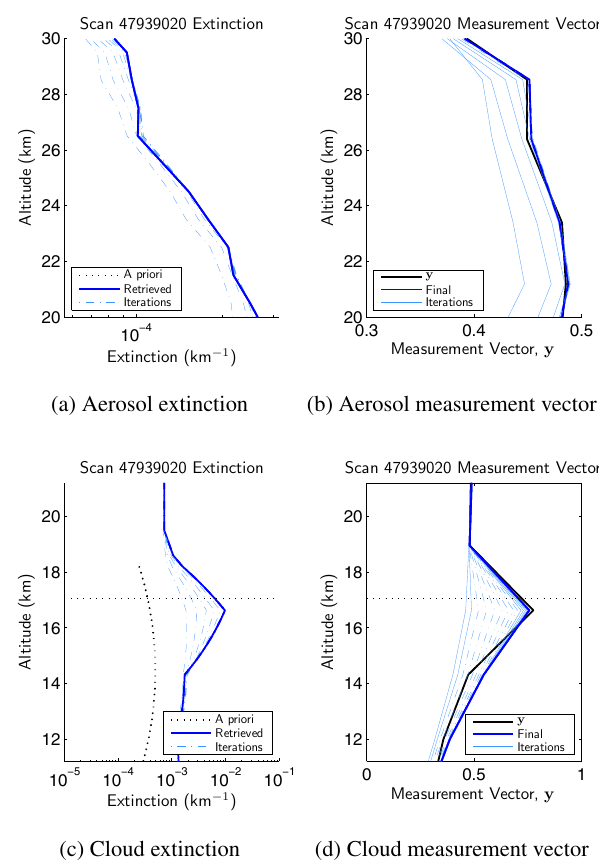
Fig. 13. Stratospheric and UTLS profiles of retrieved extinction and Fig. 13: Stratospheric and UTLS profiles of retrieved extinc- measurement vectors for OSIRIS scan tion and measurement vectors for OSIRIS scan 47939020.